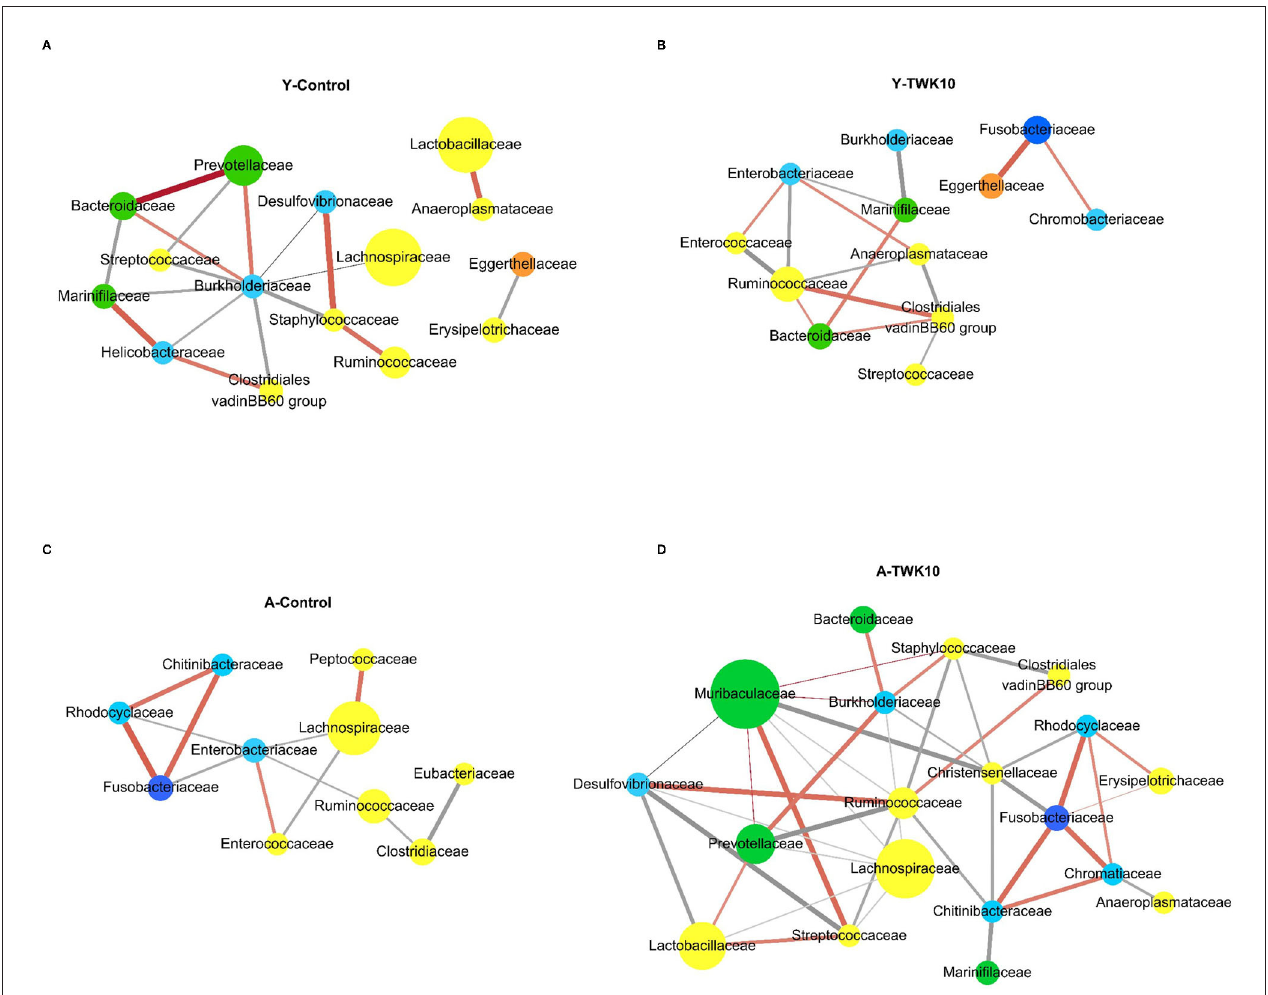
FIGURE 5 | Co-occurrence network analysis of the gut microbiota. Co-occurrence networks were performed at the family level on the basis of relative abundances in the (A) young control mice (Y-Control), (B) young TWK10-treated mice (Y-TWK10), (C) aged control mice (A-Control), and (D) aged TWK10-treated mice (A-TWK10). A connection indicated a strong (SParCC’s rho cut-off = 0.6) and significant ( P < 0.01) correlation. Each node represents a family and is colored according to its phylum; yellow: Firmicutes , green: Bacteroidetes , light blue: Proteobacteria , dark blue: Fusobacteria , orange: Actinobacteria . The node size represents the relative abundance of each family (if > 1%) in each group. Each edge represents a positive correlation (orange red line) or a negative correlation (gray line) between the two families with a SparCC’s correlation coefficient of ± 0.6, and edge shading indicating correlation